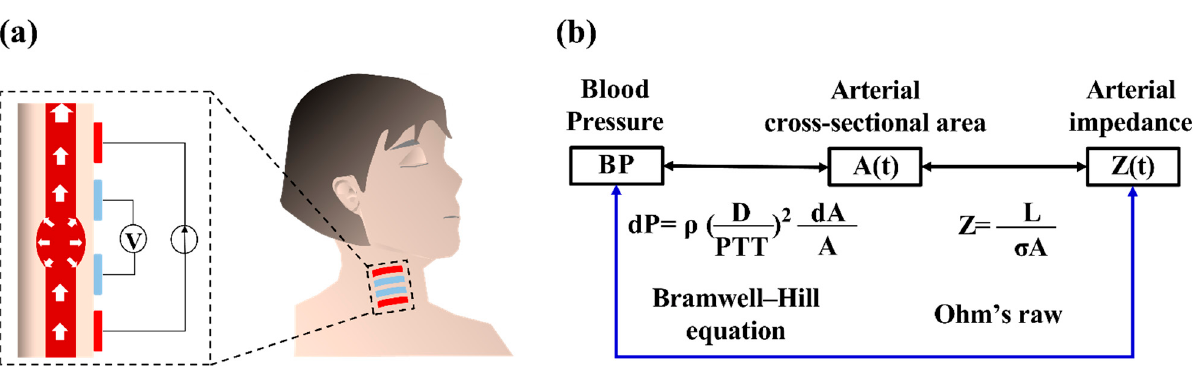
Figure 1. ( a ) Schematic of the IPG technique for hemodynamic measurement. ( b ) Physiological correlation between arterial impedance and blood pressure.